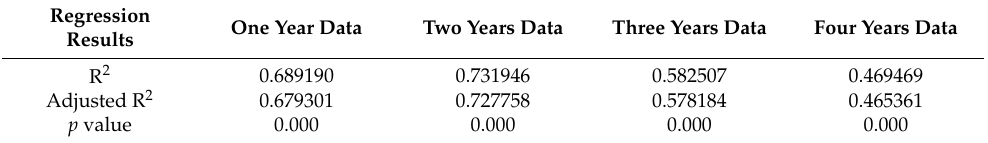
Table 10. Regression results of random-effects model using different time scales of panel data. Regression Results One Year Data Two Years Data Three Years Data Four Years Data R 2